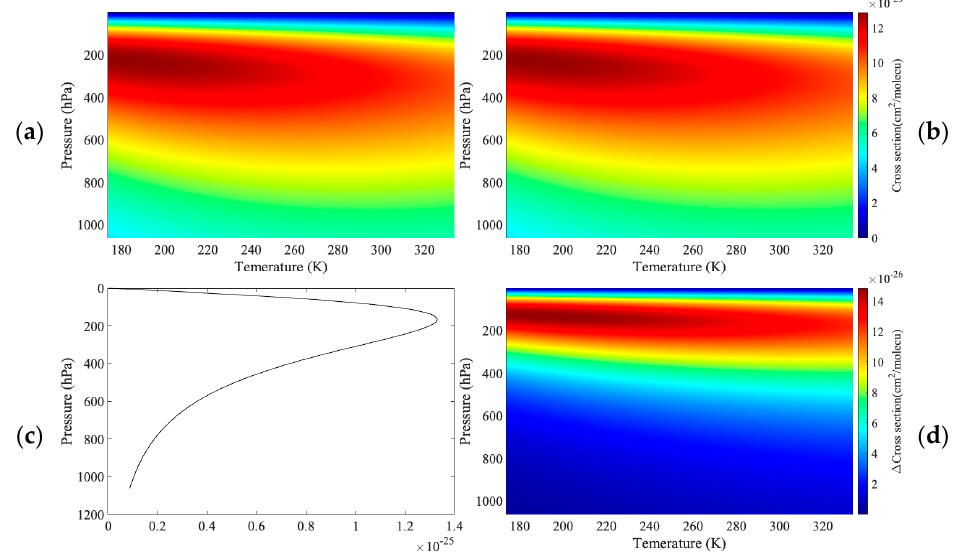
Figure 13. The comparison of the differential absorption cross sections at different temperatures and pressures: ( a ) differential absorption cross section without Doppler shift; ( b ) differential absorption cross section with Doppler shift; ( c ) longitudinal section of the deviations between (a) and (b) at 296 K; ( d ) absolute deviations of the differential absorption cross section between (a) and (b).